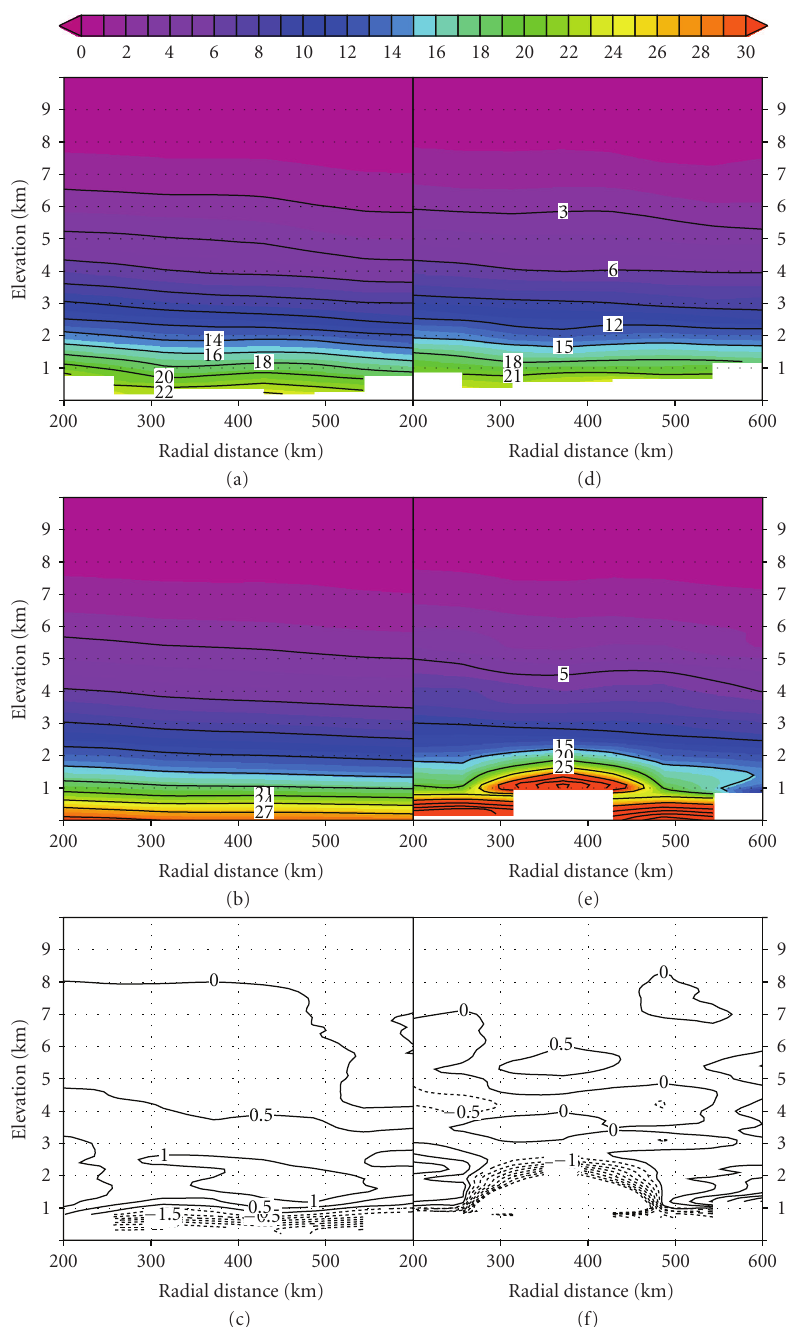
Figure 5: Same as Figure 4 except for water vapor pressure (hPa). Elevations from the surface to 10-meters are only considered due the lack of appreciable water vapor in the middle- to